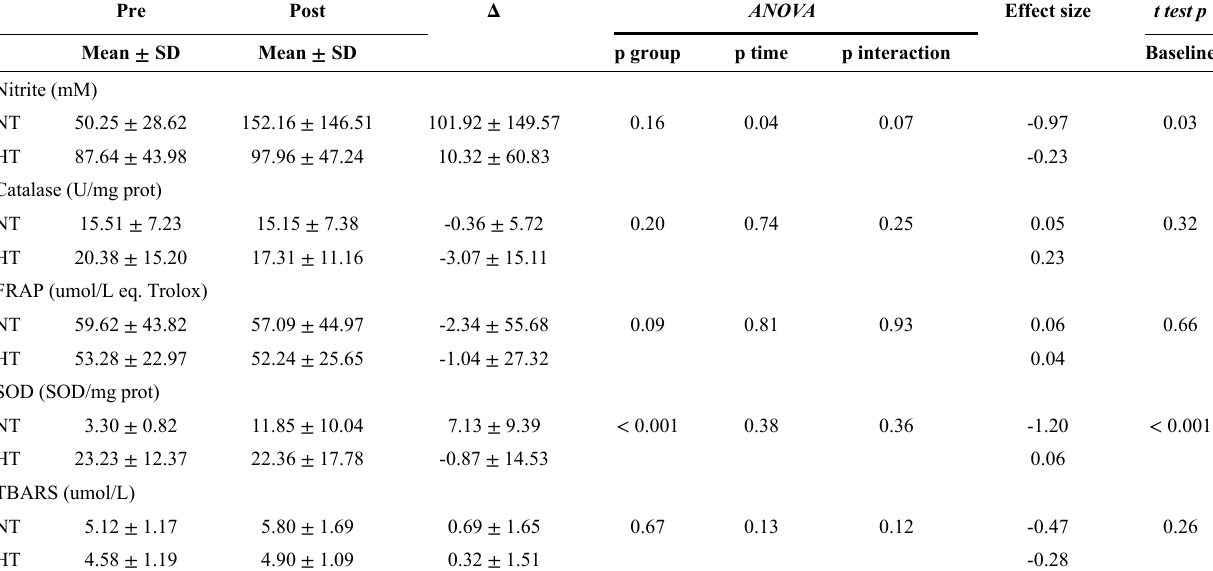
Table 2 - Salivary oxidative stress markers in HTand NT before and after